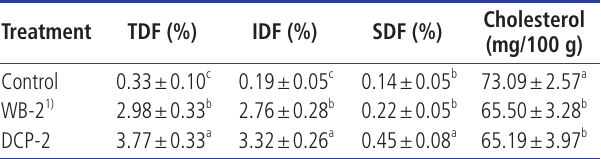
Table 3. Dietary fibre and cholesterol content of wheat bran and dried carrot pomace incorporated chicken